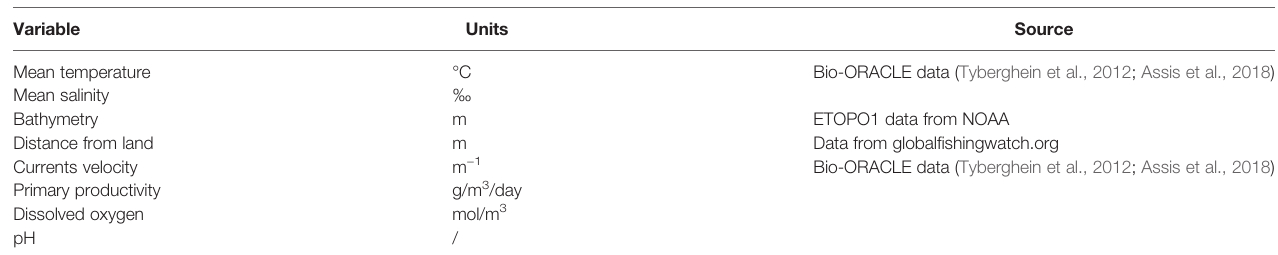
TABLE 1 | Environmental predictors used in the ensemble SDM.